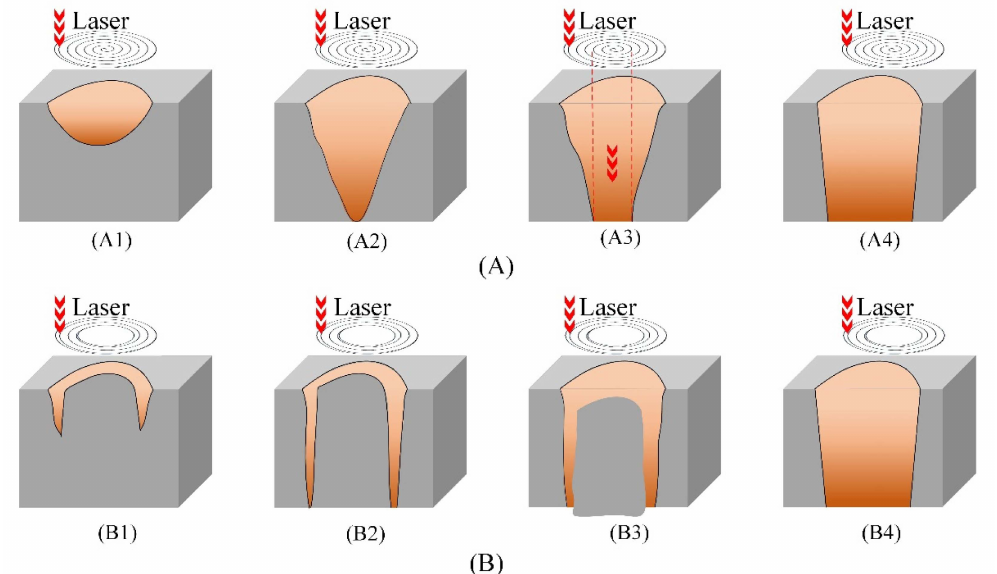
Figure 5. Schematic diagram of filled spiral laser trepanning and multiple rings laser trepanning machining mechanisms, ( A ) Filled spiral laser trepanning, ( A1 ) Material removed layer by layer, ( A2 ) Material penetrated in the center, ( A3 ) Outlet expansion, ( A4 ) Outlet has reached the saturated state, ( B ) Multiple rings laser trepanning, ( B1 ) Ring-shaped removal of the material, ( B2 ) Ring cutting gap was formed, ( B3 ) Material at the center fell off from the outlet, ( B4 ) The outlet reached the saturated